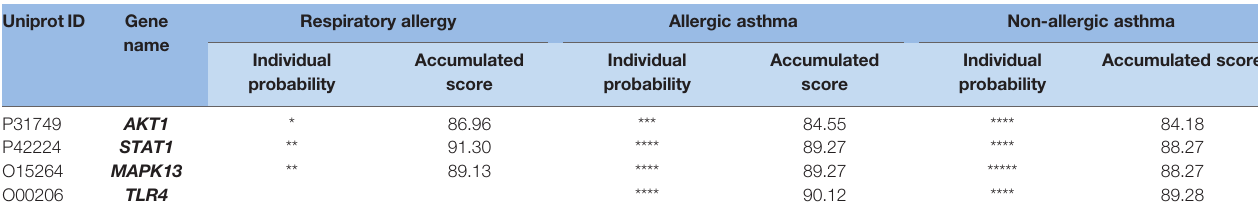
TABLE 8 | Results of triggering analysis of the three pathologies.